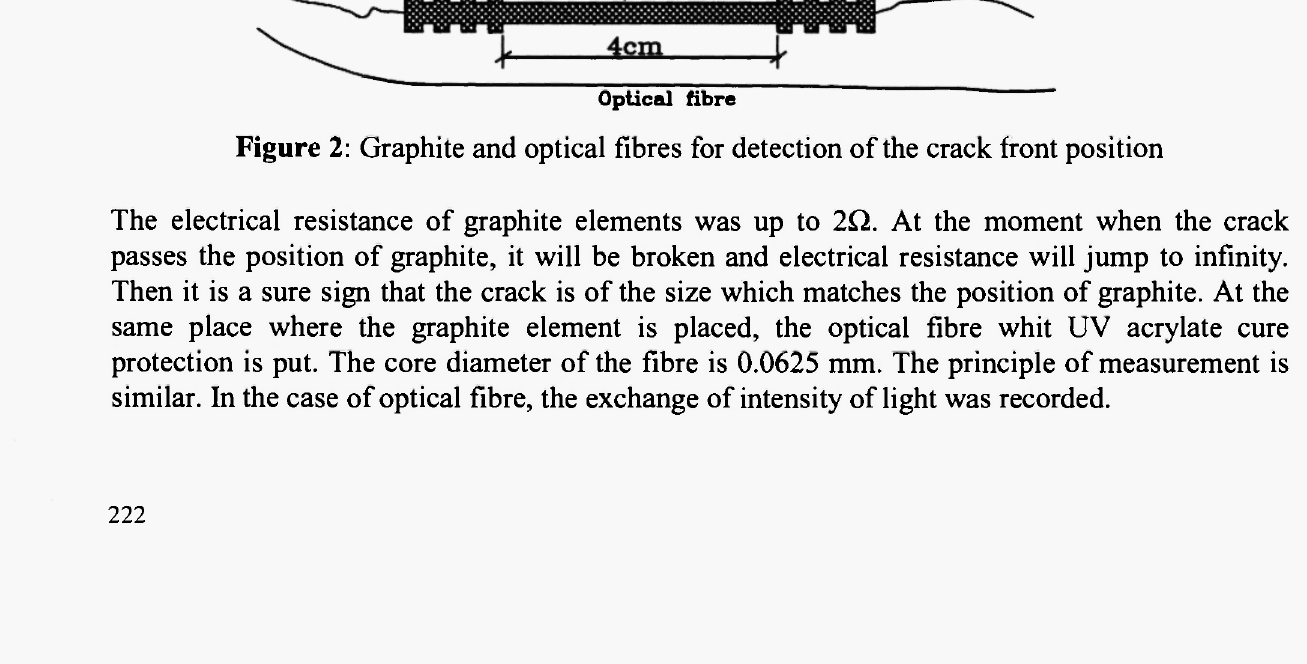
Figure 1: DCB element for plain concrete